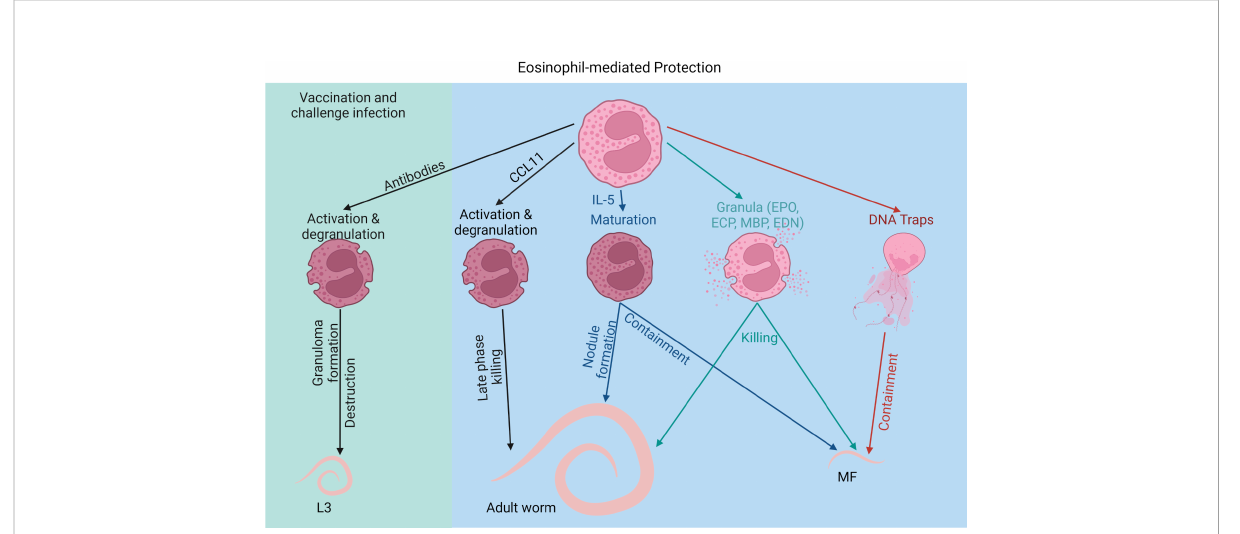
FIGURE 2 Eosinophil-mediated protection against fi larial infections. Created with